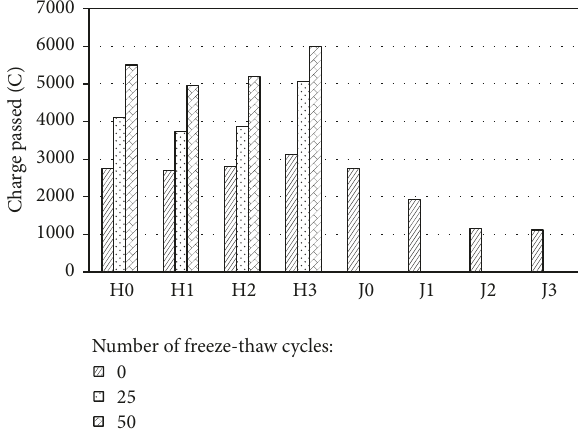
Figure 5: Charge passed of various types of